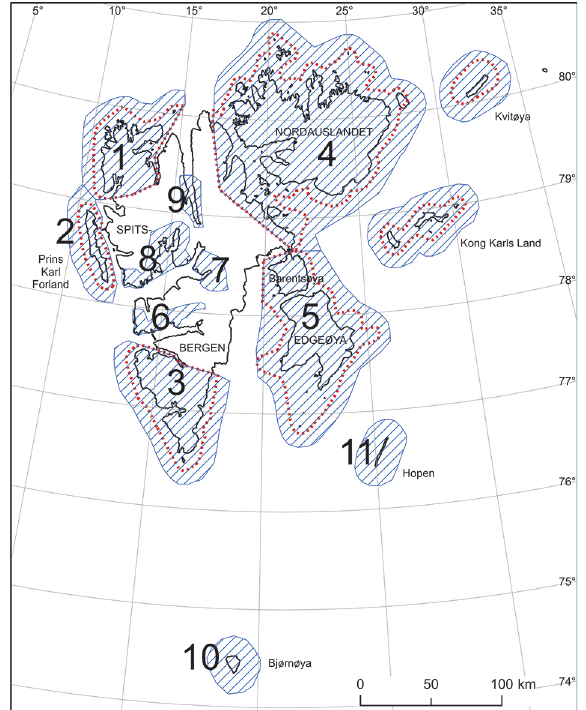
Fig. 4. large protected areas in Svalbard. Their boundaries from 1973 are singed with the red dotted line, their current extent is hachured. In 2004, the extent of territorial water was widened from 4 to 12 nautical miles, enlarging the protected areas. Elaborated on the basis of: Ministry of Environment 1984, Protected areas in Svalbard